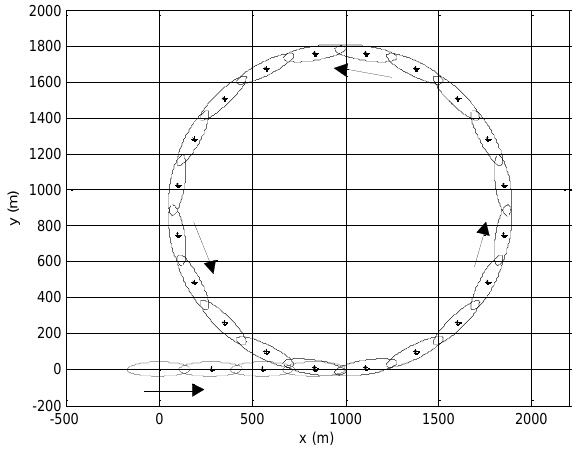
Figure 2. Target trajectory of simulation scenario